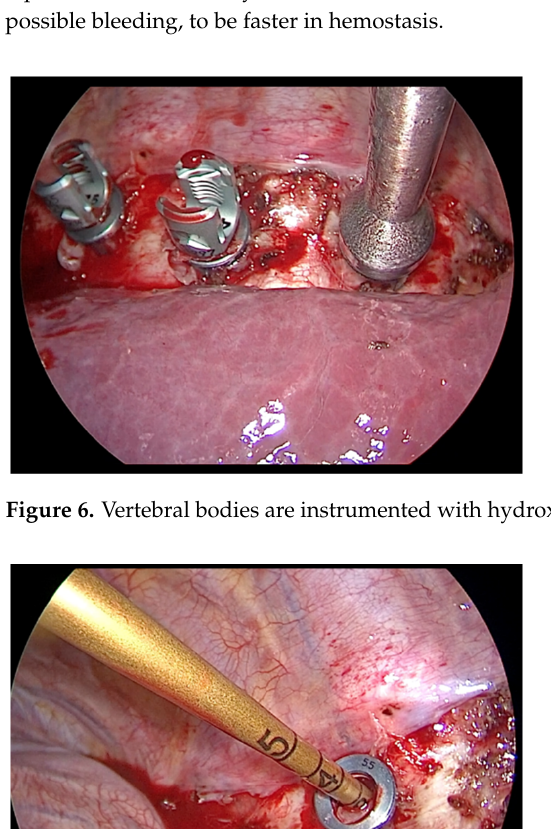
Figure 5. The intercostal vessels are identified and carefully dissected with bipolar forceps. Dissection and coagulation of the vessels below the pleura is helped through the mini-thoracotomy access with a pad mounted on Kelly instrument. This maneuver helps to keep the field clean and, in case of possible bleeding, to be faster in hemostasis.